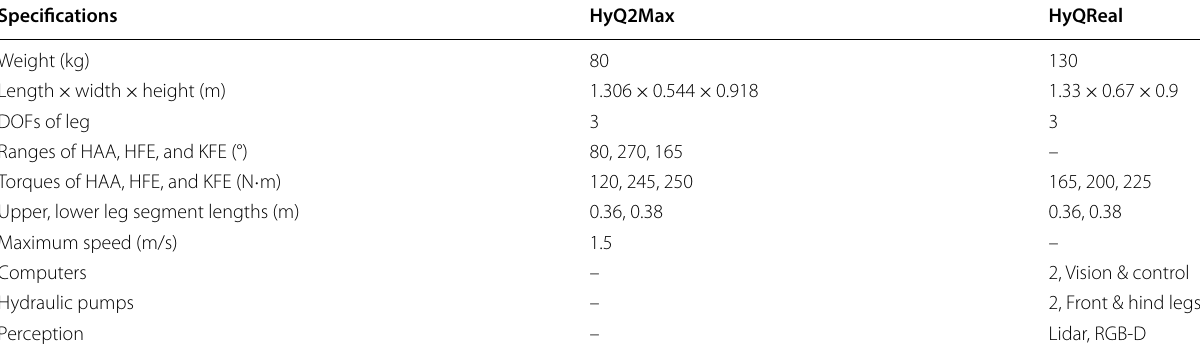
Table 1 Specifications of HyQ2Max and HyQReal [11, 15,